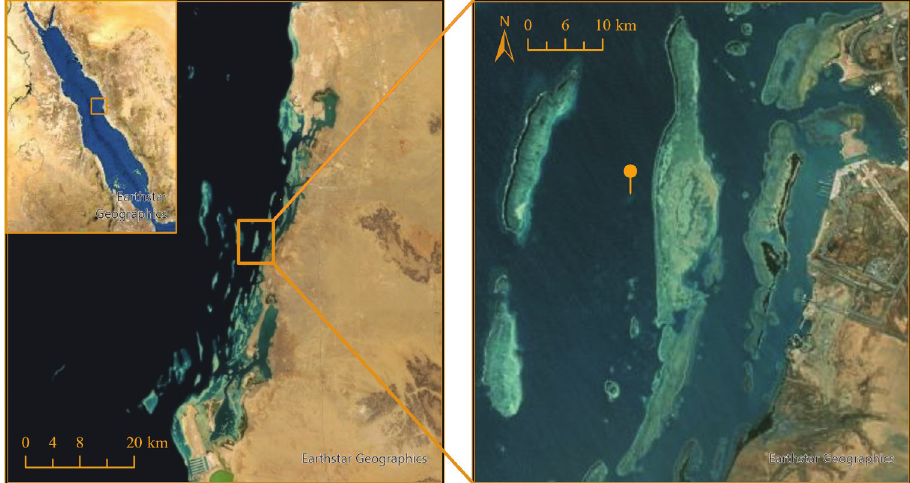
Figure 1. Location of observed Stichodactyla mertensii on an inshore Red Sea reef near the King Abdullah University of Science and Technology; Thuwal, Saudi